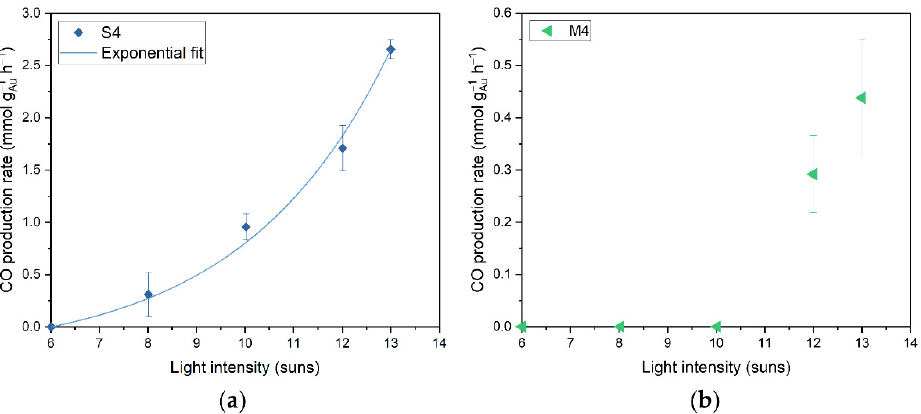
Figure 3. ( a ) CO production rate as function of light intensity for the S4 catalyst. The curve is an exponential fit for the S4 dataset; ( b ) CO production rate as function of light intensity for the M4 catalyst. Error bars represent a 98% confidence interval. Reaction conditions: flow process with a mixture of CO 2 :H 2 :N 2 (8 mL min − 1 :8 mL min − 1:4 mL min − 1 ) at 3.5 bar pressure, 200 mg catalyst, varied intensity irradiation from solar simulator (AM1.5); 1 sun = 1 kW m − 2 .